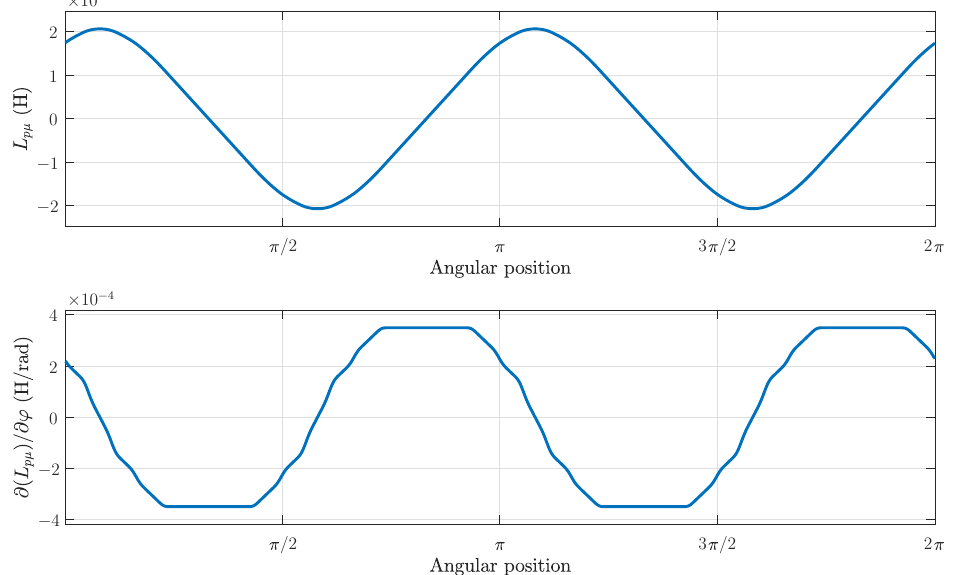
Figure 15. Mutual inductance between a stator winding and rotor bar of the tested machine as a function of the rotor position ( top ), and its angular derivative ( bottom ).